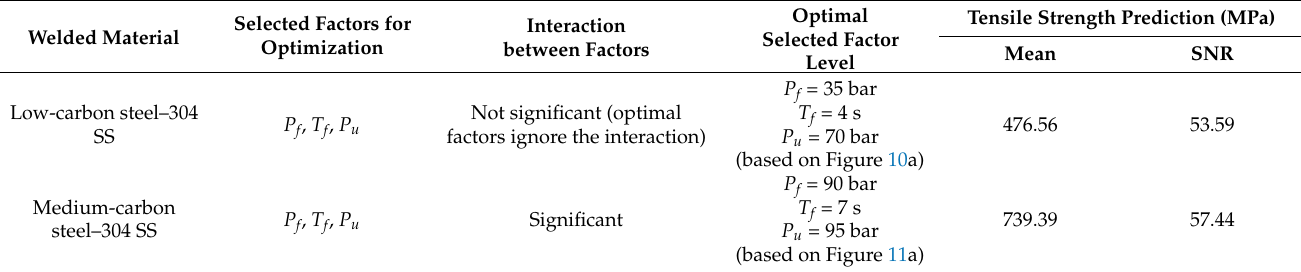
Table 11. Optimal factor levels based on Taguchi